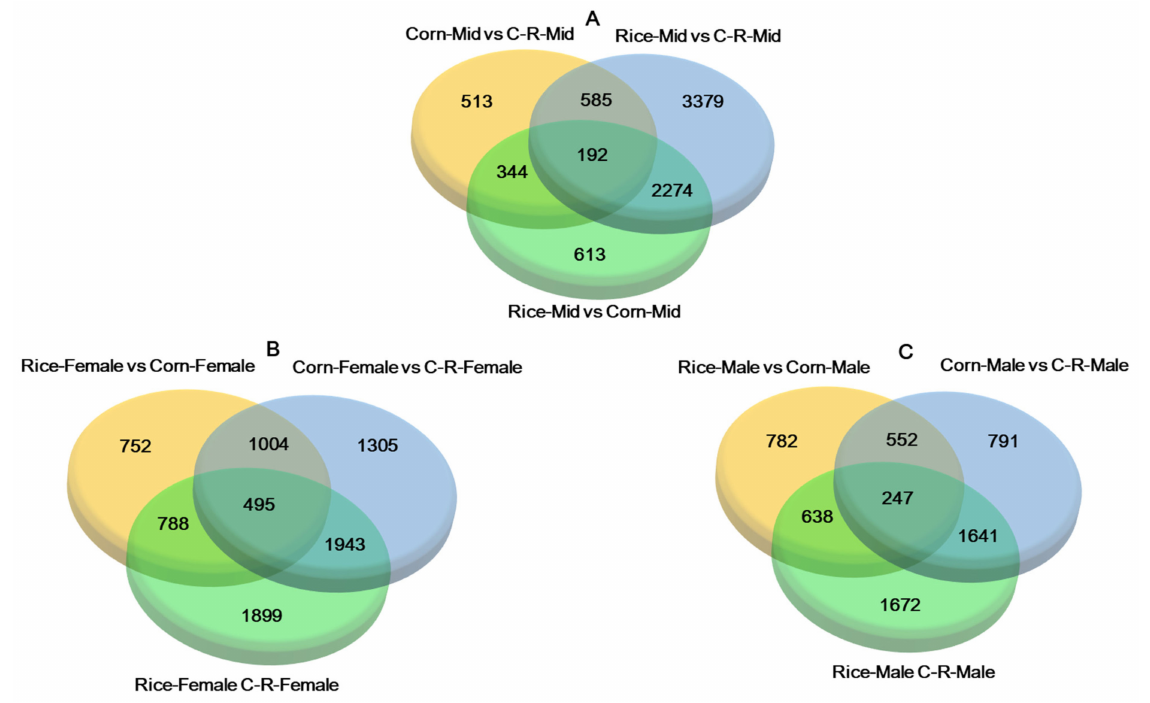
Figure 7. Venn diagrams depicting overlap among differentially expressed genes (log2 (FC) ≥ 1, FDR < 0.05) from pairwise comparisons among the three populations of Spodoptera frugiperda . The number of co-expressed unigenes in the Corn- midgut vs. C-R-Midgut, Rice-midgut vs. C-R-Midgut and Rice-midgut vs. Corn-Midgut ( A ), Rice-female vs. Corn-female, Corn-female vs. C-R-female (After 20 generation the corn population was fed on rice for one generation (C-R-female)) and Rice-female vs. C-R-female ( B ) and Rice-male vs. Corn-male, Corn-male vs. C-R-male and Rice-male vs. C-R-male antennae ( C